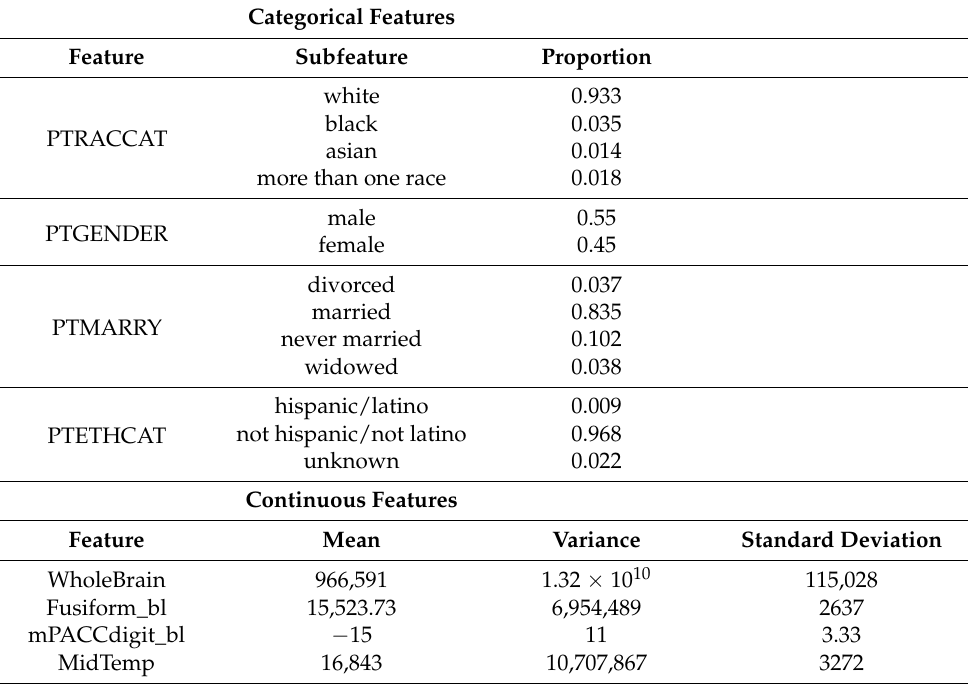
Table 2. Descriptive statistics for categorical and continuous ADNI patient